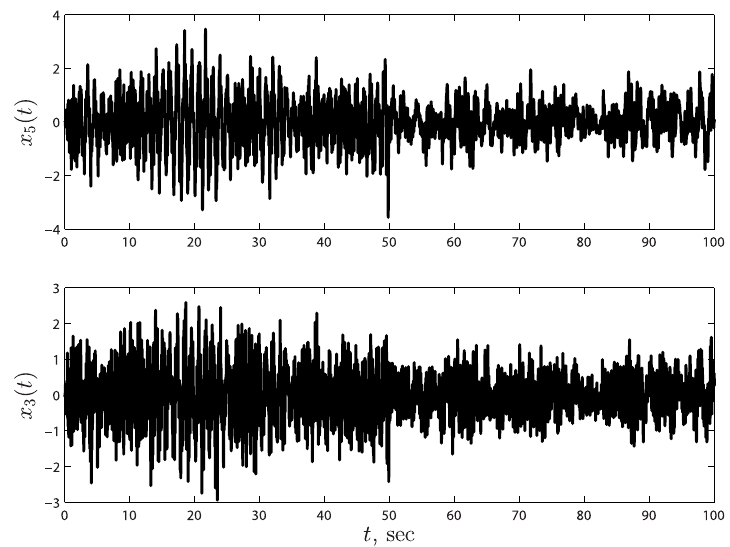
Fig. 5. Typical floor measurements showing the overall damage of the system at t = 50